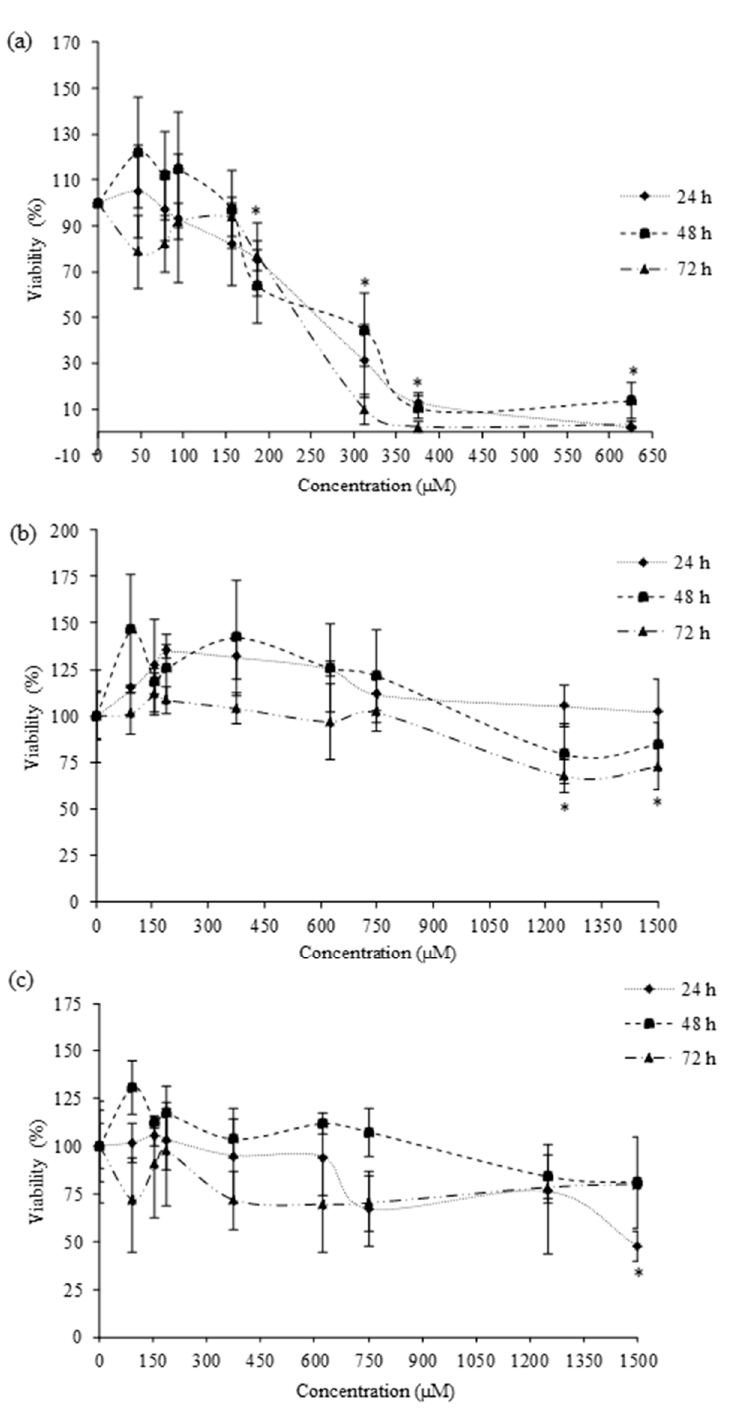
Figure 3. Cell viability of ( a ) amitraz, ( b ) 2,4-DMF, and ( c ) 2,4-DMA on HepG2 cells by total protein content assay after 24, 48, and 72 h of exposure. Results are expressed as mean ± SEM (n = 3). (*) p ≤ 0.05 indicates significantly differences from control.